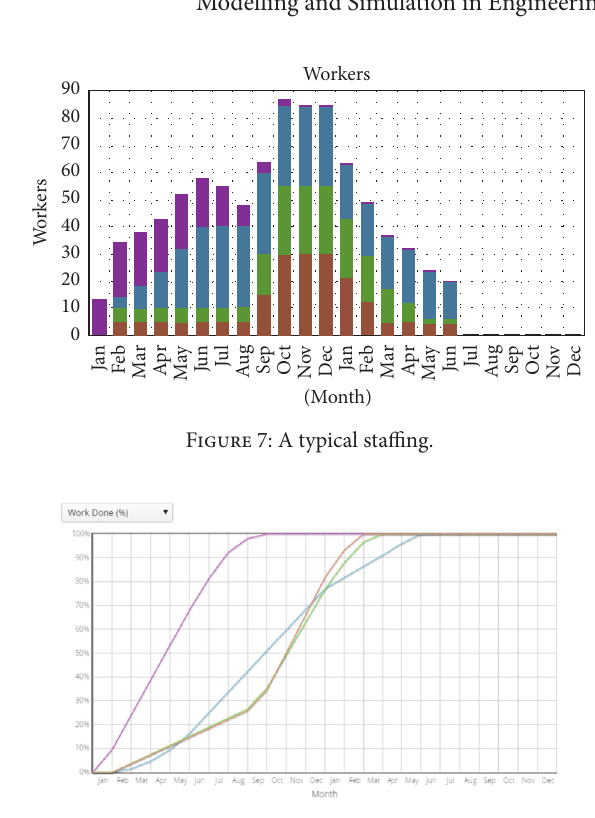
Figure 8: The progress outcome estimate of the typical